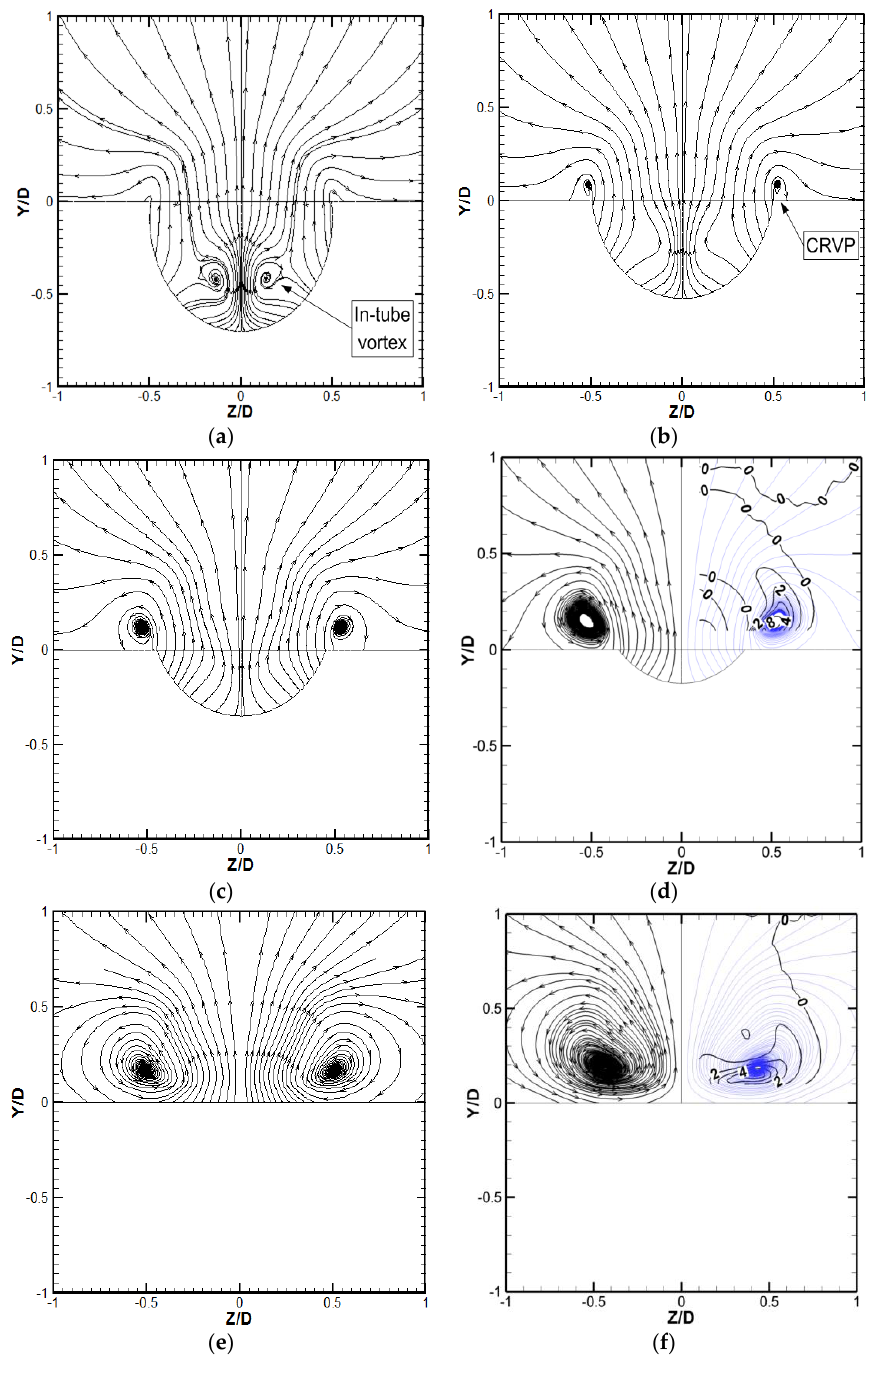
Figure 4. Baseline 2D streamlines at the Y-Z planes around the exit (Br = 1). ( a ) X/D = −1; ( b ) X/D = −0.75; ( c ) X/D = −0.5; ( d ) X/D = −0.25 ( ω x contours in blue); ( e ) X/D = 0; ( f ) X/D = 0.5 ( ω x contours in blue ). A similar CRVP formation process was observed in Case 3, the unsteady flow simulation case.